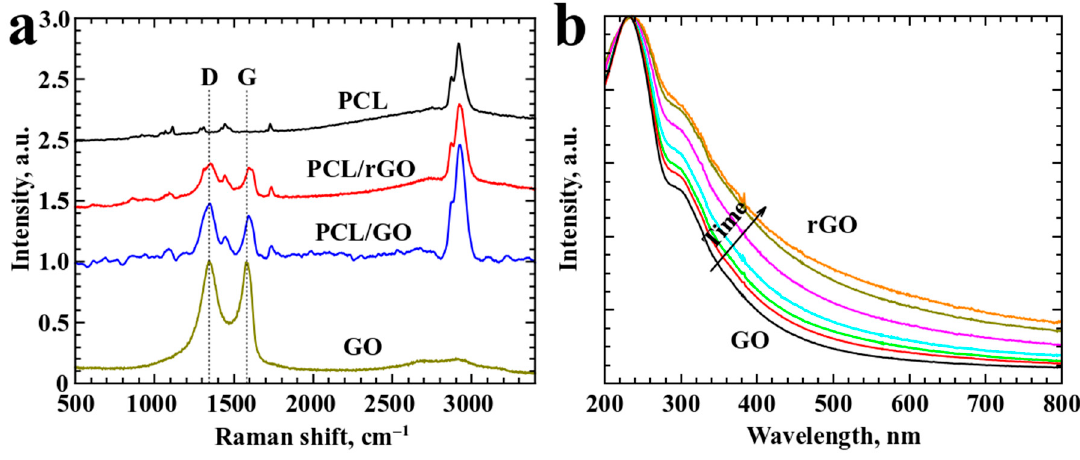
Figure 4. ( a ) Raman spectra of samples and ( b ) absorption spectra of GO solutions after di ff erent thermal treatment times (t max = 8 h, 80 ◦